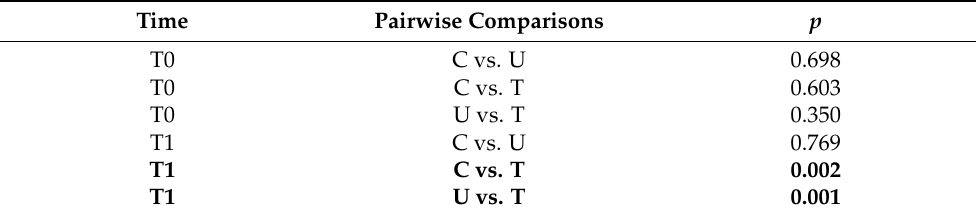
Table 1. Pairwise comparisons among managements (Uncultivated: U, Control: C, and Treated: T) before (T0) and after (T1) the trap crop experiment. Significant differences are indicated in bold. Time Pairwise Comparisons p T0 C vs. U 0.698 T0 C vs. T 0.603 T0 U vs. T